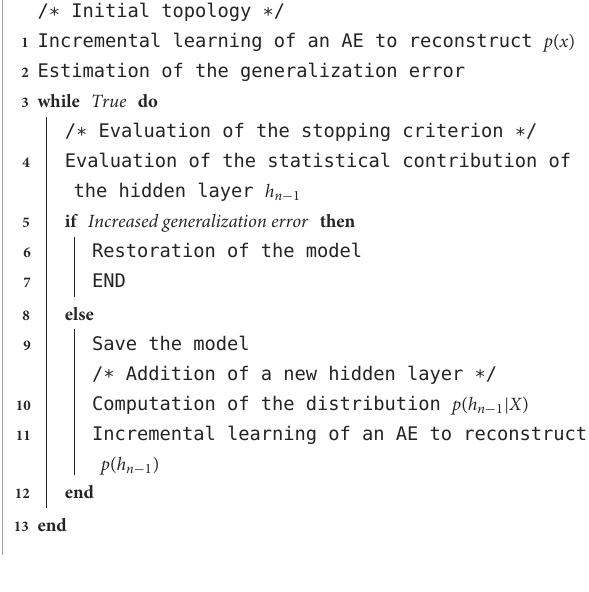
Algorithm 2. Unsupervised incremental